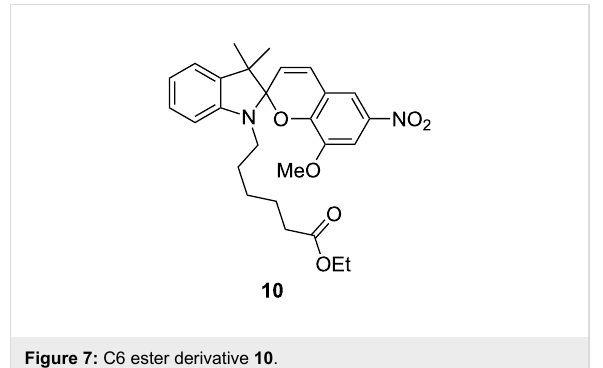
is the defining factor in merocyanine stabilisation and that only beyond a threshold distance does hydrogen bond donation of the carboxylic acid become important. This is a key point in designing functional materials based on N -alkylcarboxyspiropy- rans.